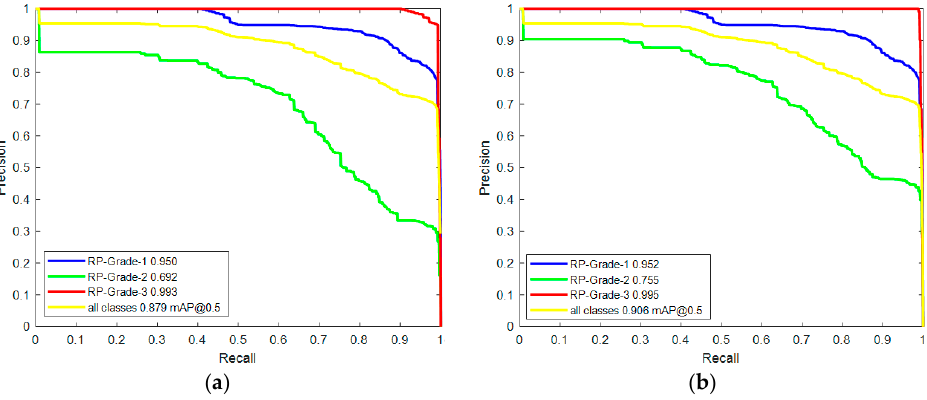
Figure 13. Comparison of YOLOv5 and Im-YOLOv5 PR curve. ( a ) YOLOv5; ( b ) Im-YOLOv5. As can be seen from Figure 13, the Im-YOLOv5 model has improved the grading accuracy for different apple quality levels, with higher mAP of over 95% for Grade-1 and Grade-3 apples. The mAP for Grade-2 apples reached 0.755, an improvement of 9.1% over the original model. The average accuracy for all apple grades was 0.906, an increase of 3.1% compared to the original model.